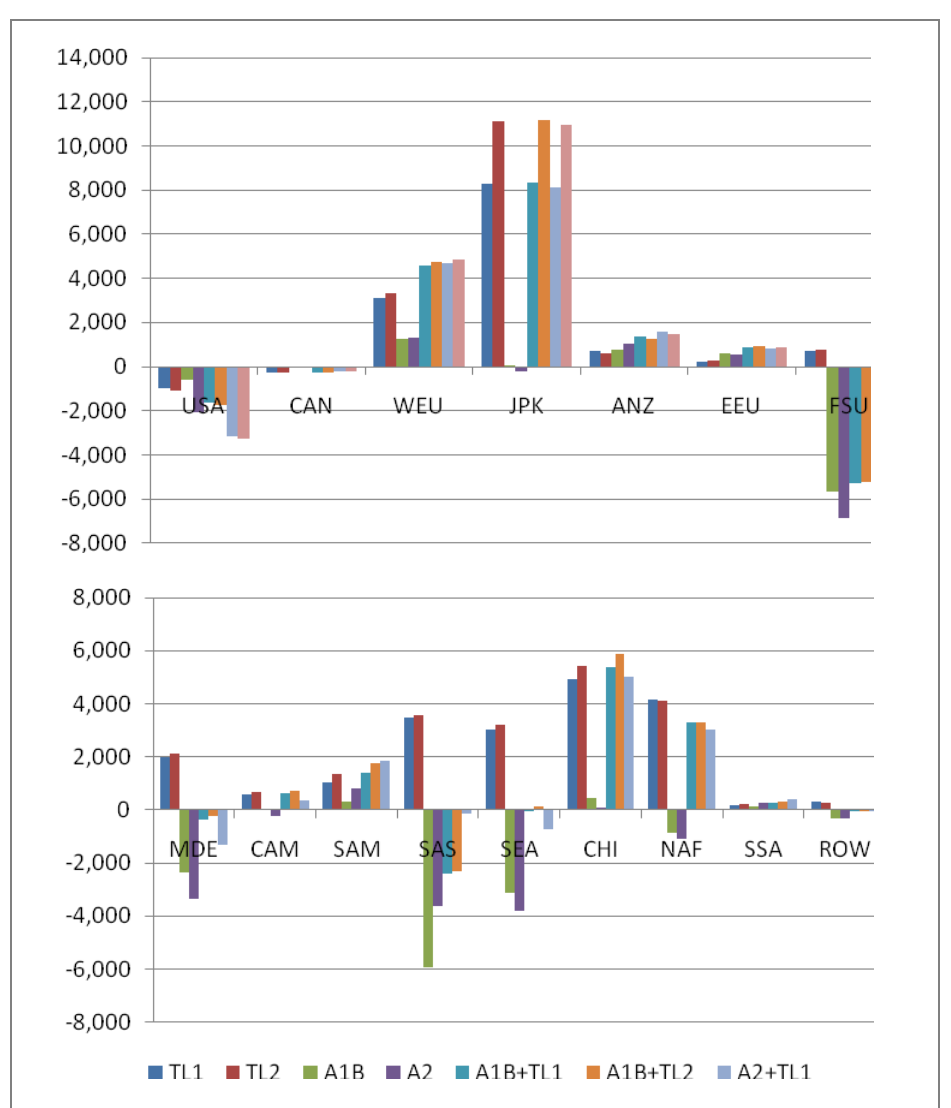
Note: Developed regions (top panel) and developing regions (bottom